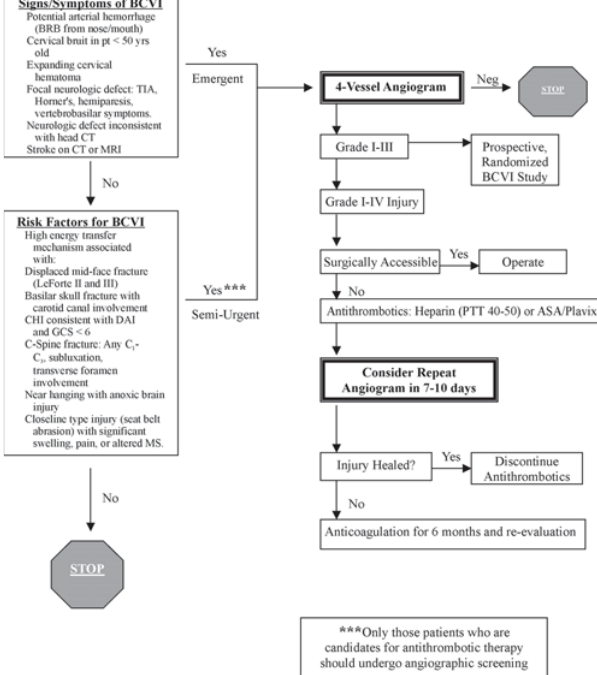
Figure 2 - Denver screening and treatment algorithm for